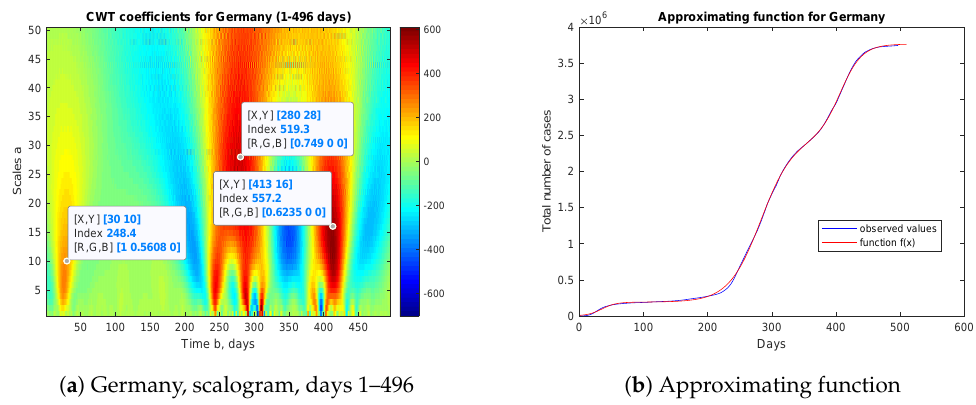
Figure 2. Scalogram and the approximating multilogistic function (23) for Germany.